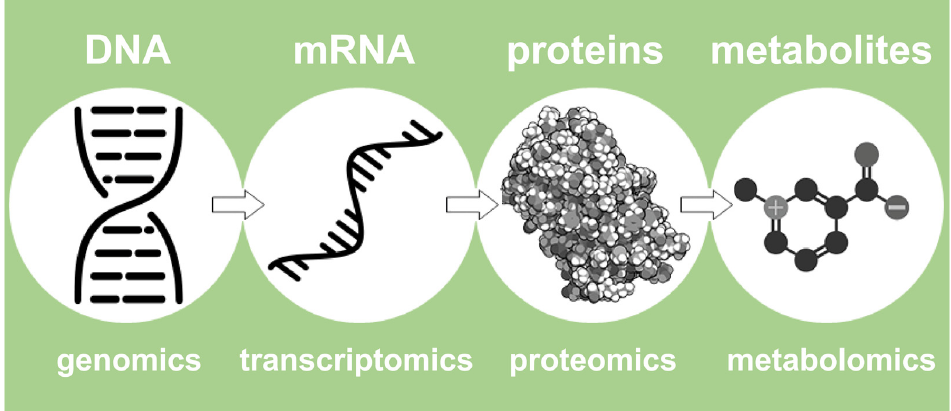
Figure 2. An outline of the four most important omics fields, ranging from genomics to metabolomics.